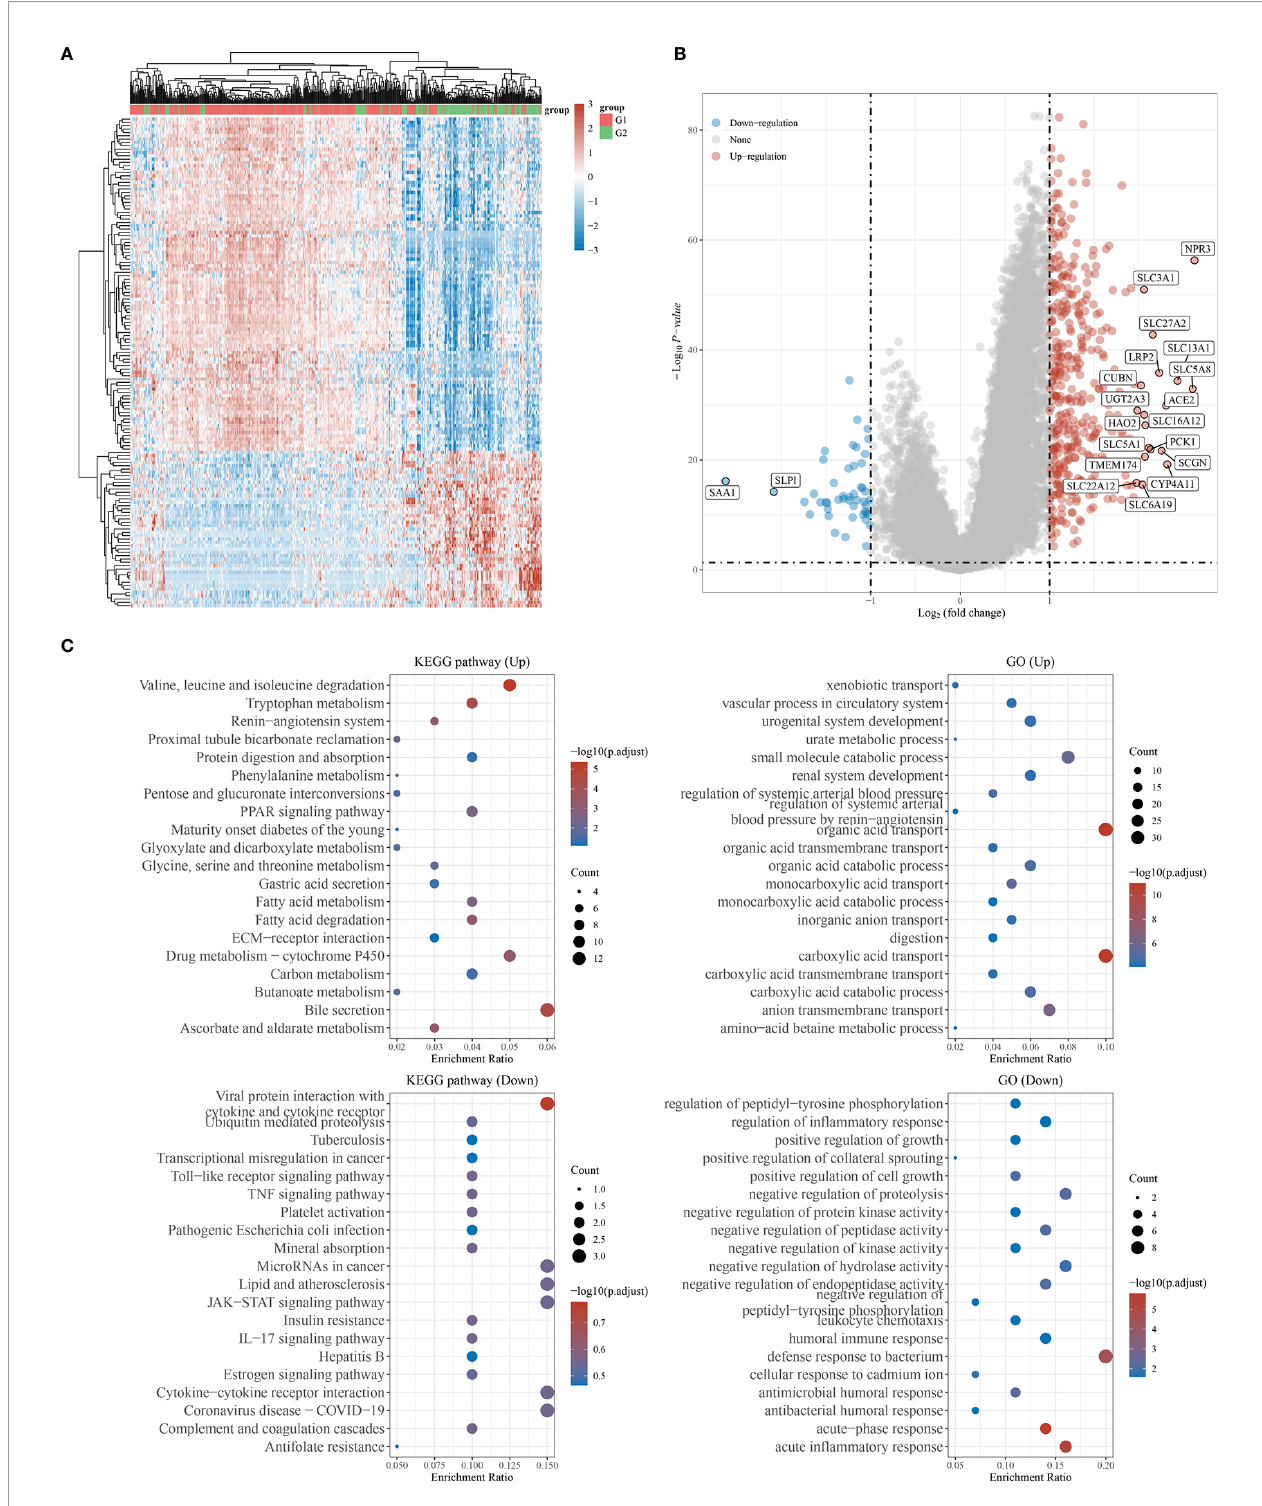
FIGURE 6 | GO and KEGG analysis of the DEGs in between G1 subtype and G2 subtype. (A) Heat map showing the differential genes. (B) Volcano plot of differential gene expression analysis. (C) GO and KEGG enrichment analysis. (|LogFC|>1, Adjusted P <0.05).